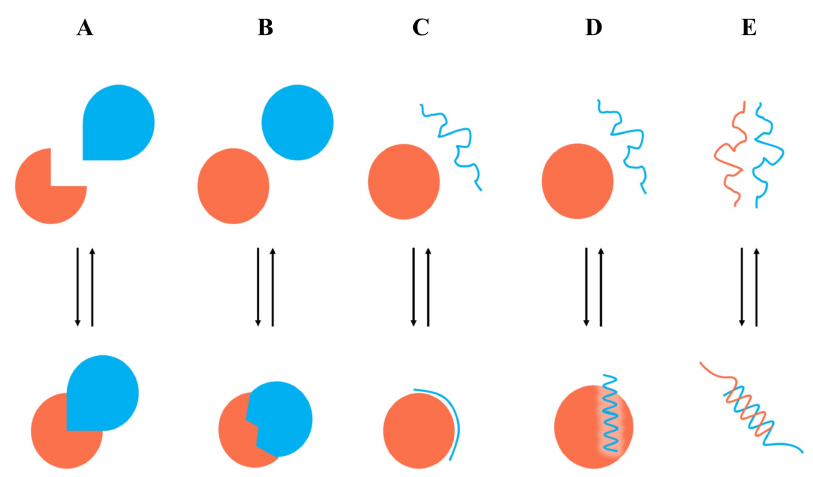
Figure 1. Classification of protein–protein interactions. ( A ) Type I, two proteins interact through preformed surfaces. ( B ) Type II, two globular proteins interact through an induced binding surface. ( C ) Type III, a rigid globular protein interacts with a peptide. ( D ) Type IV, a flexible globular protein interacts with a peptide. ( E ) Type V, interaction between two peptide chains.